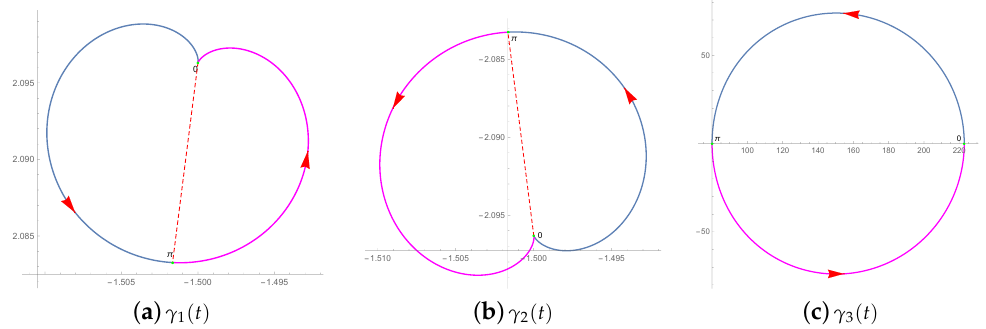
Figure 3. Boundary curves of the three red fixed components Ω .